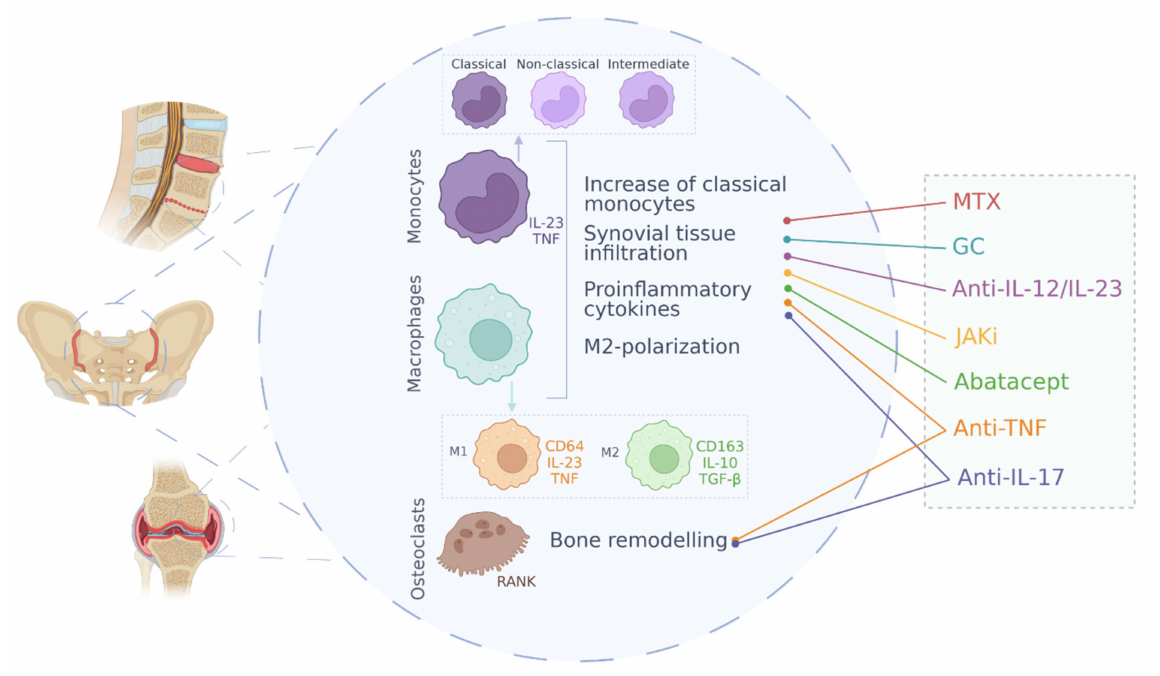
Figure 1. Schematic overview of monocytes and macrophage roles in spondyloarthritis and effect of current therapies. MTX (methrotrexate), GC (glucocorticoids), JAKi (JAK